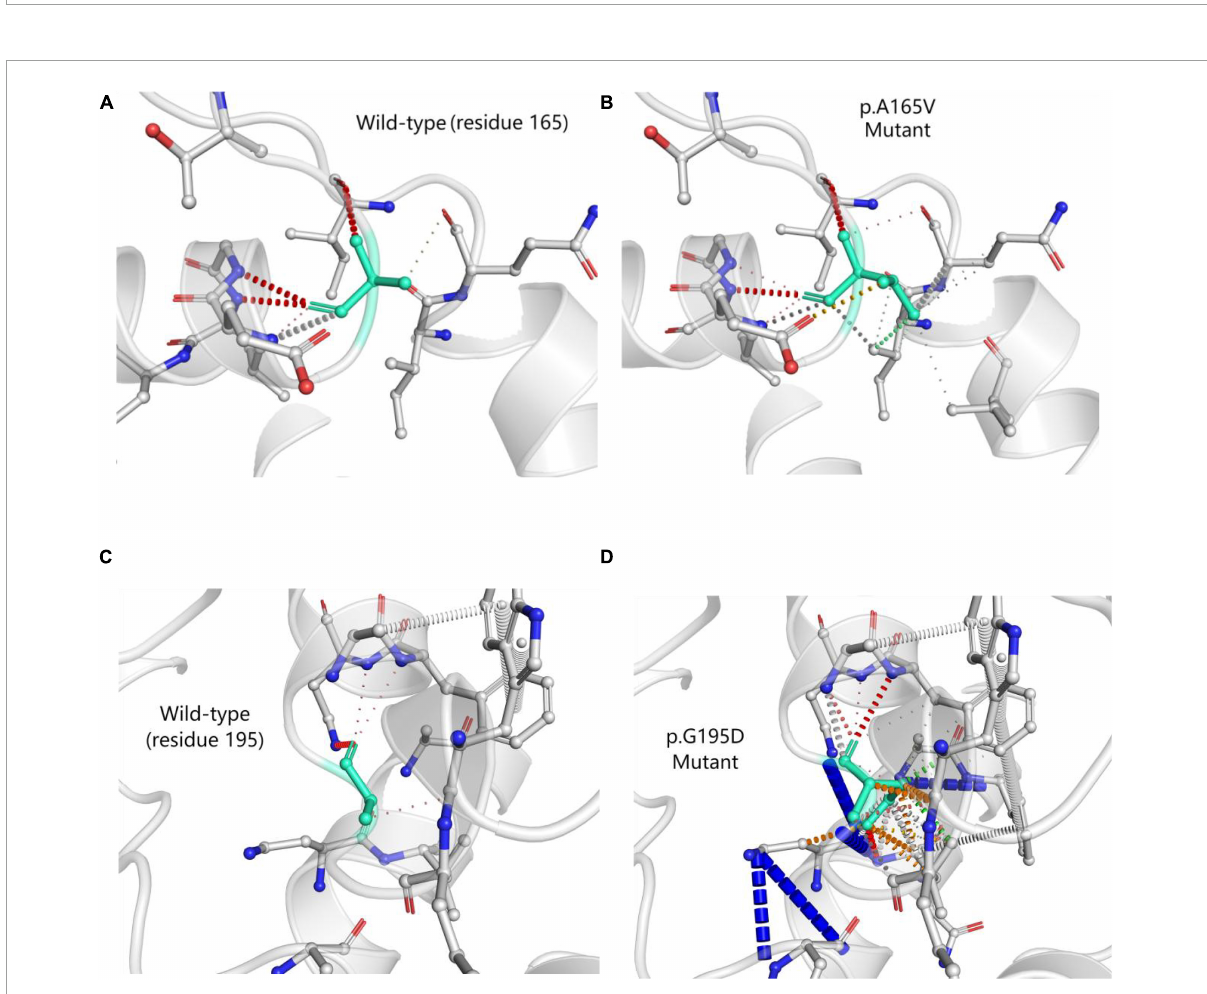
FIGURE5 Prediction of interatomic interactions of p.A165V (A,B) and p.G195D (C,D) . Residues 165 and 195 in the wild-type and mutant proteins (p.A165V and p.G195D) are colored in light green and are shown as sticks. The respective chemical interactions are labeled as dotted lines and colored as follows: hydrogen bonds—(red), weak hydrogen bonds—(orange), hydrophobic contacts—(green), amide-amide contacts—(blue), and ionic interactions—(gold). Amino acid residues are also colored according to type, namely; nitrogen (blue), oxygen (red), and sulfur (yellow). In comparison with wild-type sites, some interactions were observed to be added in mutant